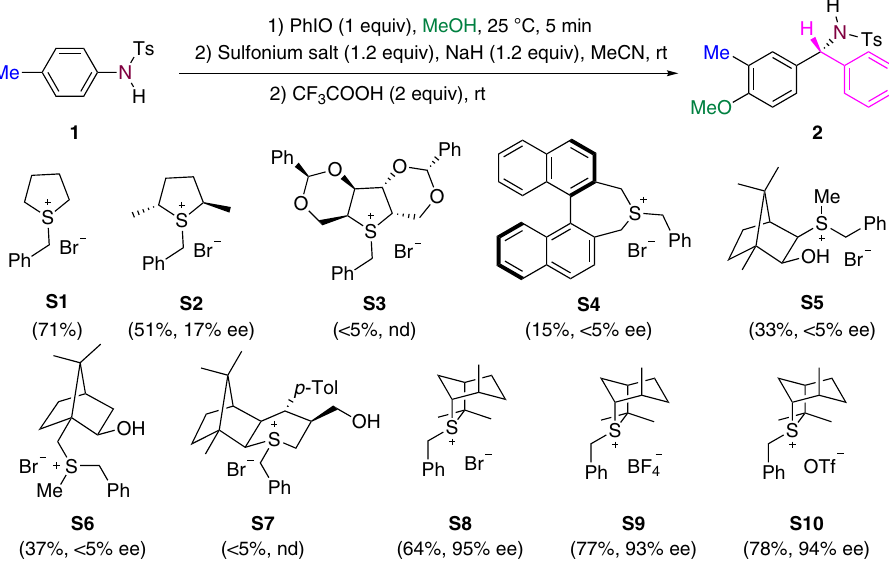
Fig. 3 Evaluation of sulfur ylides. nd not